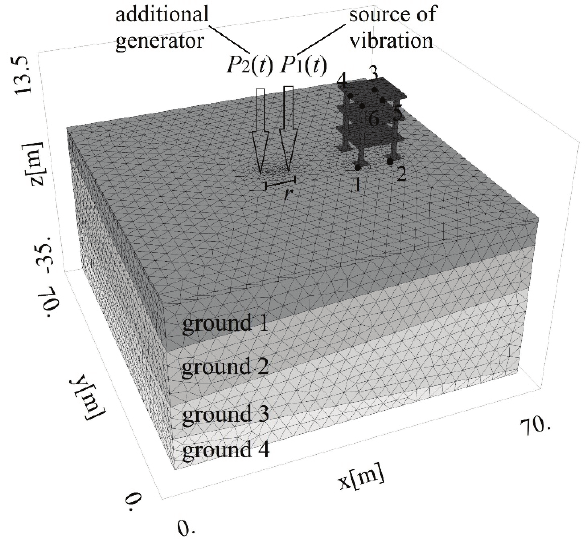
Fig. 1. Domain with the vibration source and additional generator